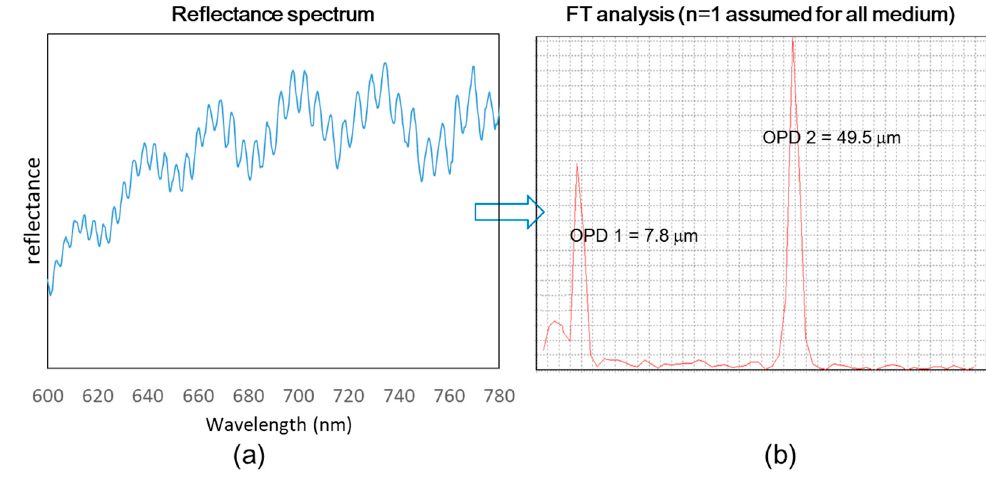
Figure 10. ( a ) Reflectance spectrum from PL measurement of the BGA sample. ( b ) FT spectrum of OPD 1 and OPD 2 corresponding to the two distinct frequencies of oscillations, which are well separated.